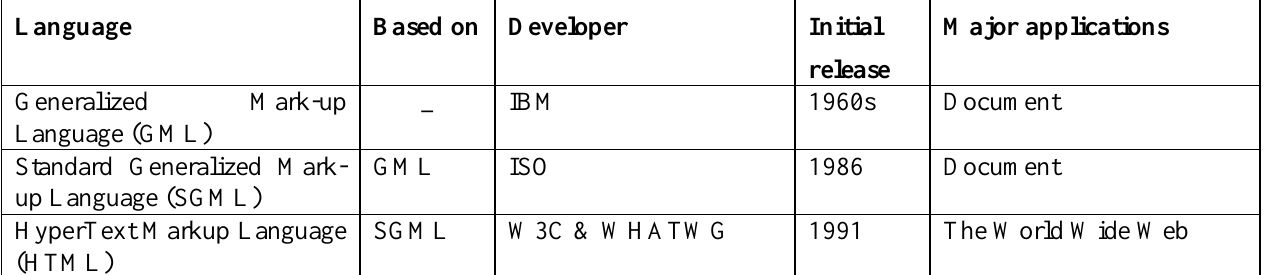
Table 1. Summary of the core markup